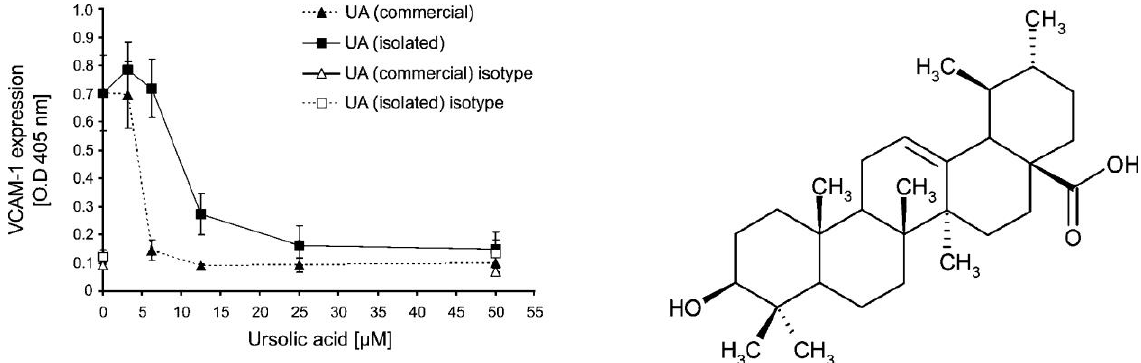
Figure 6 . Study of ursolic acid's anti-inflammatory activity (Schwaiger et al., 2011) A lot of research has been done on the extraction of these valuable compounds and optimization of the parameters of extraction and selectivity of active constituents. In table 1, a summary of the processes using to extract active constituents from the herbal plant is presented. Table 1 . A summary of the processes used for extracting active constituents from herbal plant